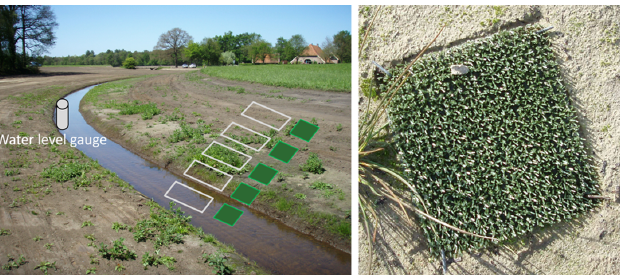
Fig 1. Field studydesign. Tomonitorseedrainalongtheentirehydrologicalgradient,threereplicatetransectsof fiveseedtraps(squarespictureleft; close-uppictureright)werepinnedtothe groundperpendicular tothe stream channel.Vegetationsurveyswerecarriedout inpermanent quadratsadjacentto eachseedtrap(rectangles; pictureleft). Streamwaterlevelswereregisteredusingpressuretransducers inwaterlevelgaugeswithin30m of thenearesttransect.